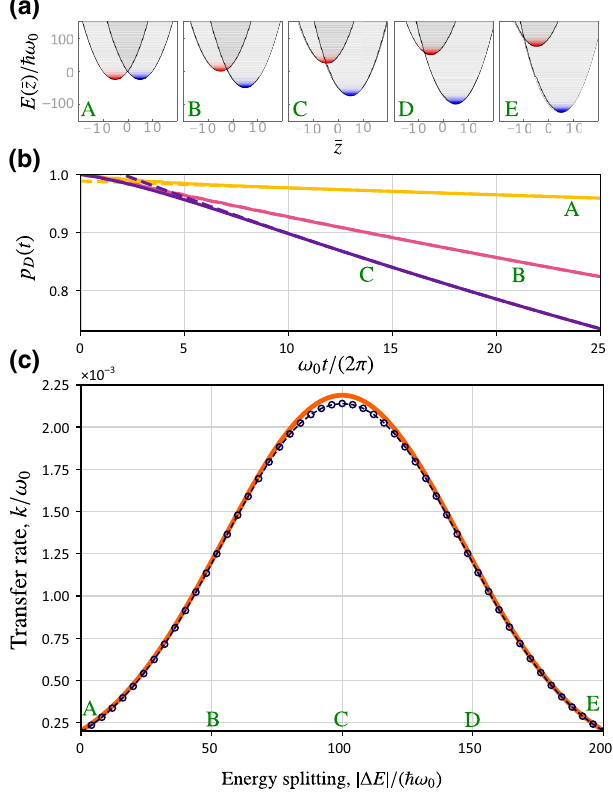
FIG. 2. Classical nonadiabatic transfer. (a) Diabatic BO energy surfaces and their vibrational levels in the classical nona- diabatic regime. The parameters are chosen as V = 0.2 (cid:2) ω 0 , g = 10 ω 0 , γ = 0.4 ω 0 / 2 π , and n = 10, corresponding to k B T ≈ 10.5 (cid:2) ω 0 and λ = 100 (cid:2) ω 0 . The panels show | (cid:2) E | = 0 (cid:2) ω 0 (A), | (cid:2) E | = 100 (cid:2) ω | (cid:2) E | = 150 (cid:2) ω | (cid:2) E | = 50 (cid:2) ω 0 (B), 0 (C), 0 (D), and | (cid:2) E | = 200 (cid:2) ω 0 (E). Vibrational states are indicated by hor- izontal gray lines and red (donor) and blue (acceptor) shaded areas indicate the thermal populations. (b) The exponential fit (dashed lines) of the time evolution of the donor-state popula- tion p D ( t ) (continuous lines) as generated by Eqs. (1) and (3), for the parameters of panels A (yellow), B (pink), and C (violet) in (a). (c) Transfer rates extracted from the exponential fits to p D ( t ) as a function of | (cid:2) E | (dark blue circles). The orange line is the prediction of classical nonadiabatic transport theory, according to the Marcus formula